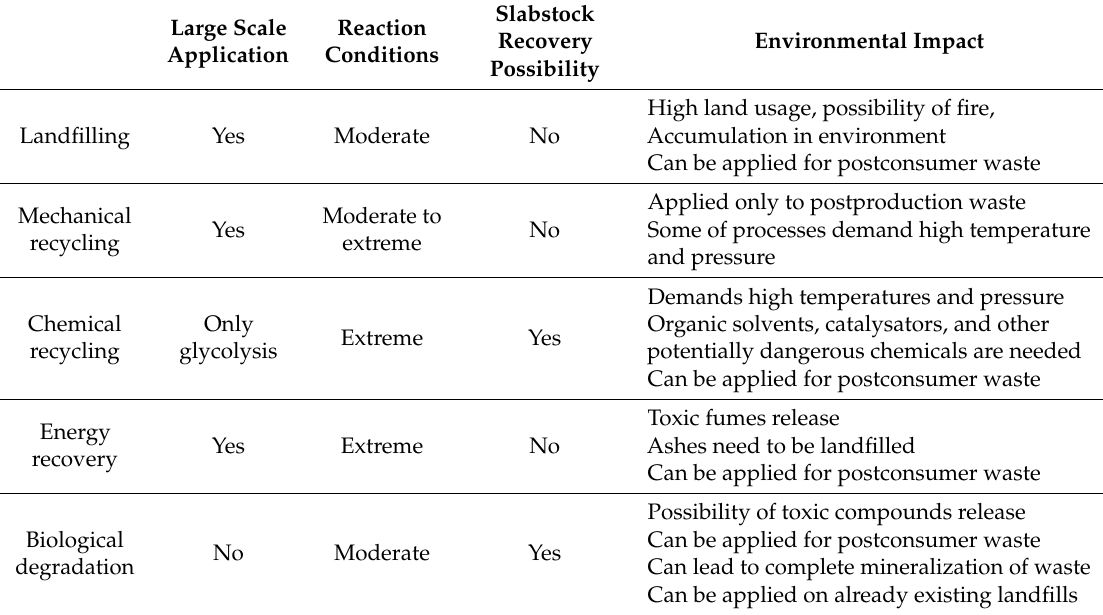
Table 5. Comparison of polyurethane recycling and degradation